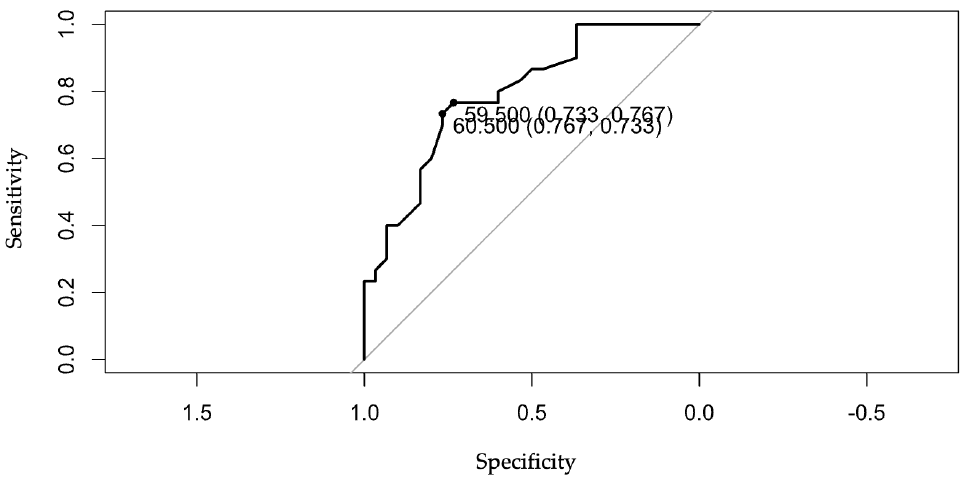
Figure 3. ROC analysis of pancreatic cancer vs. age.